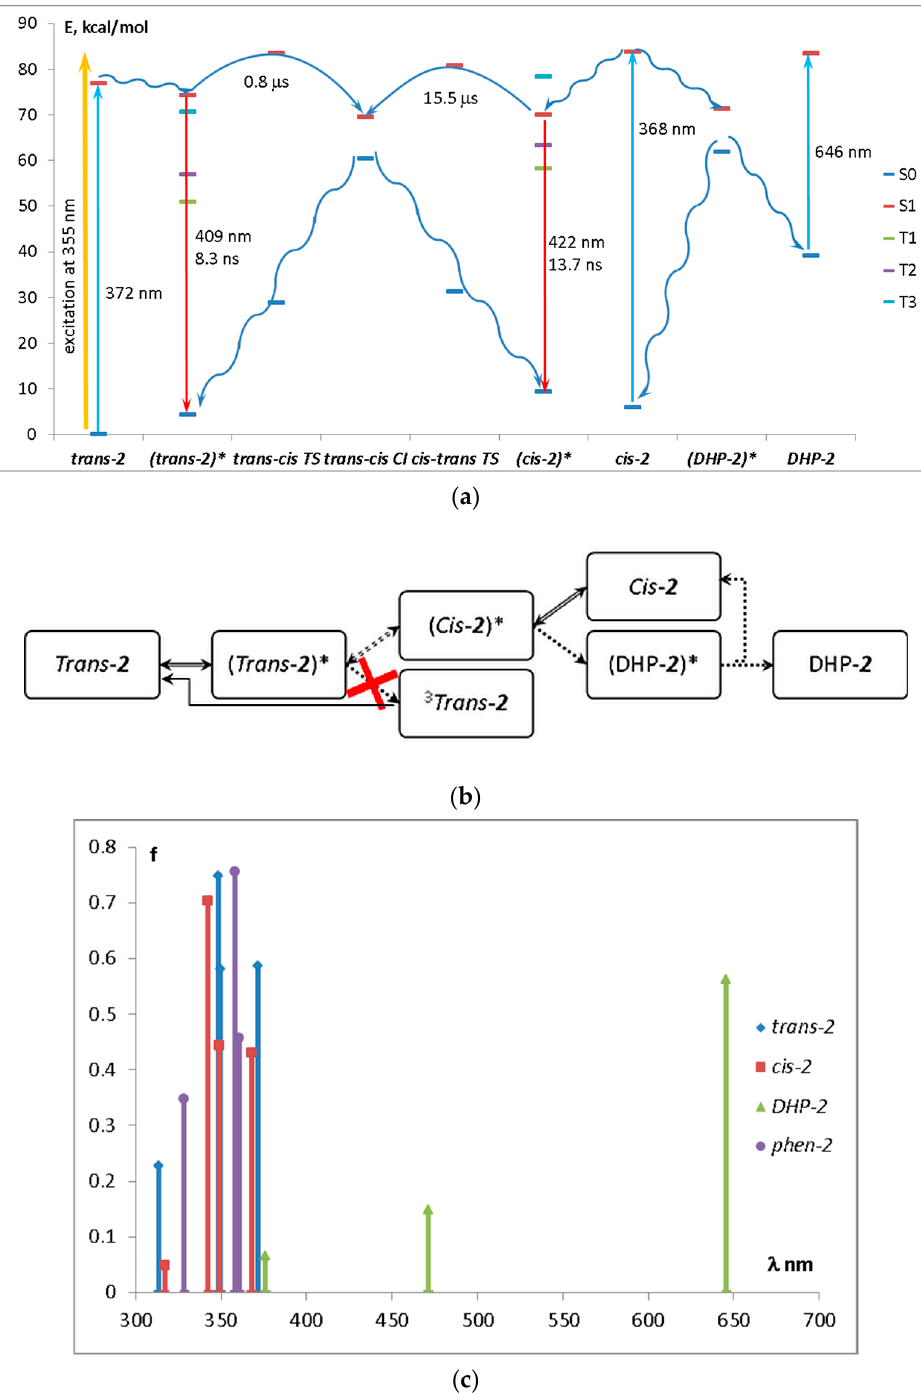
Figure 12. ( a ) Energy level diagram of diazadistyrylbenzene 2 , ( b ) scheme of its possible phototransformations, and ( c ) absorption maxima of the phototransformation products. Straight arrows on the energy diagram denote radiative processes, whereas wavy arrows denote nonradiative processes.